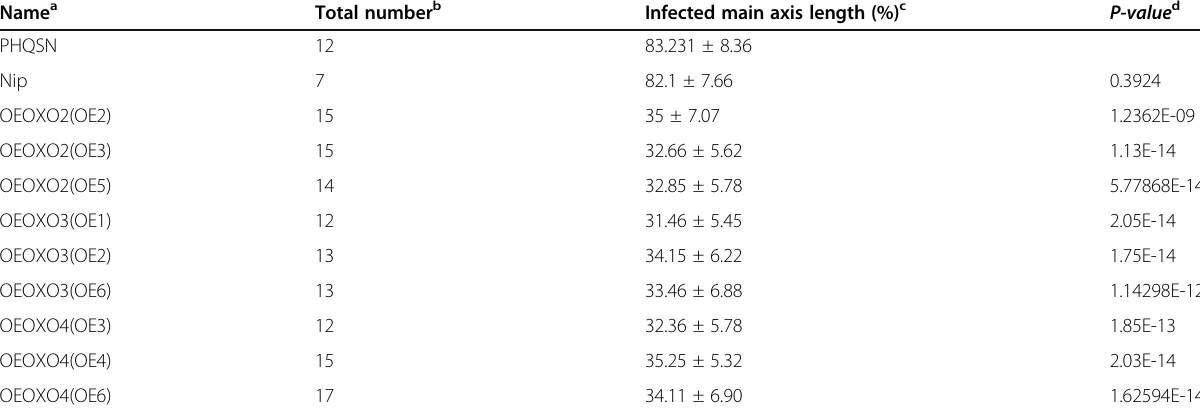
Table 1 The infected main axis length of control (PHQSN) and OXO overexpressing plants after